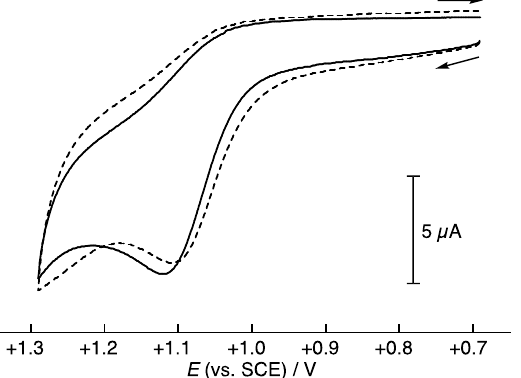
Figure 6. Cyclic voltammograms of PTS (1.0 × 10 – 3 M) (solid line) and RSV (1.0 × 10 – 3 M) (dashed line) in MeCN (0.10 M Bu 4 NClO 4 ) recorded at the scan rate of 100 mV s – 1 on a Pt working